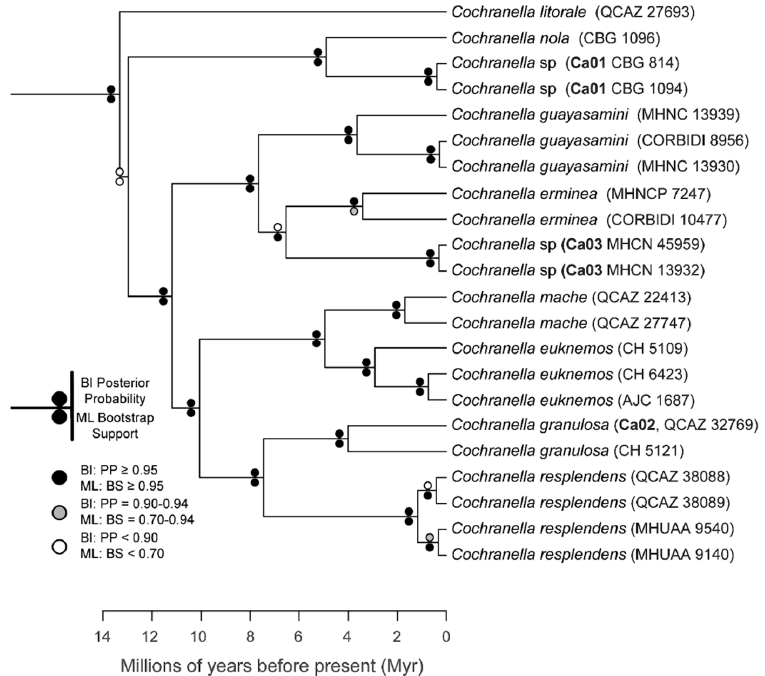
Figure 69. Evolutionary relationships among species in the genus Cochranella , inferred using maximum likelihood and Bayesian criteria.